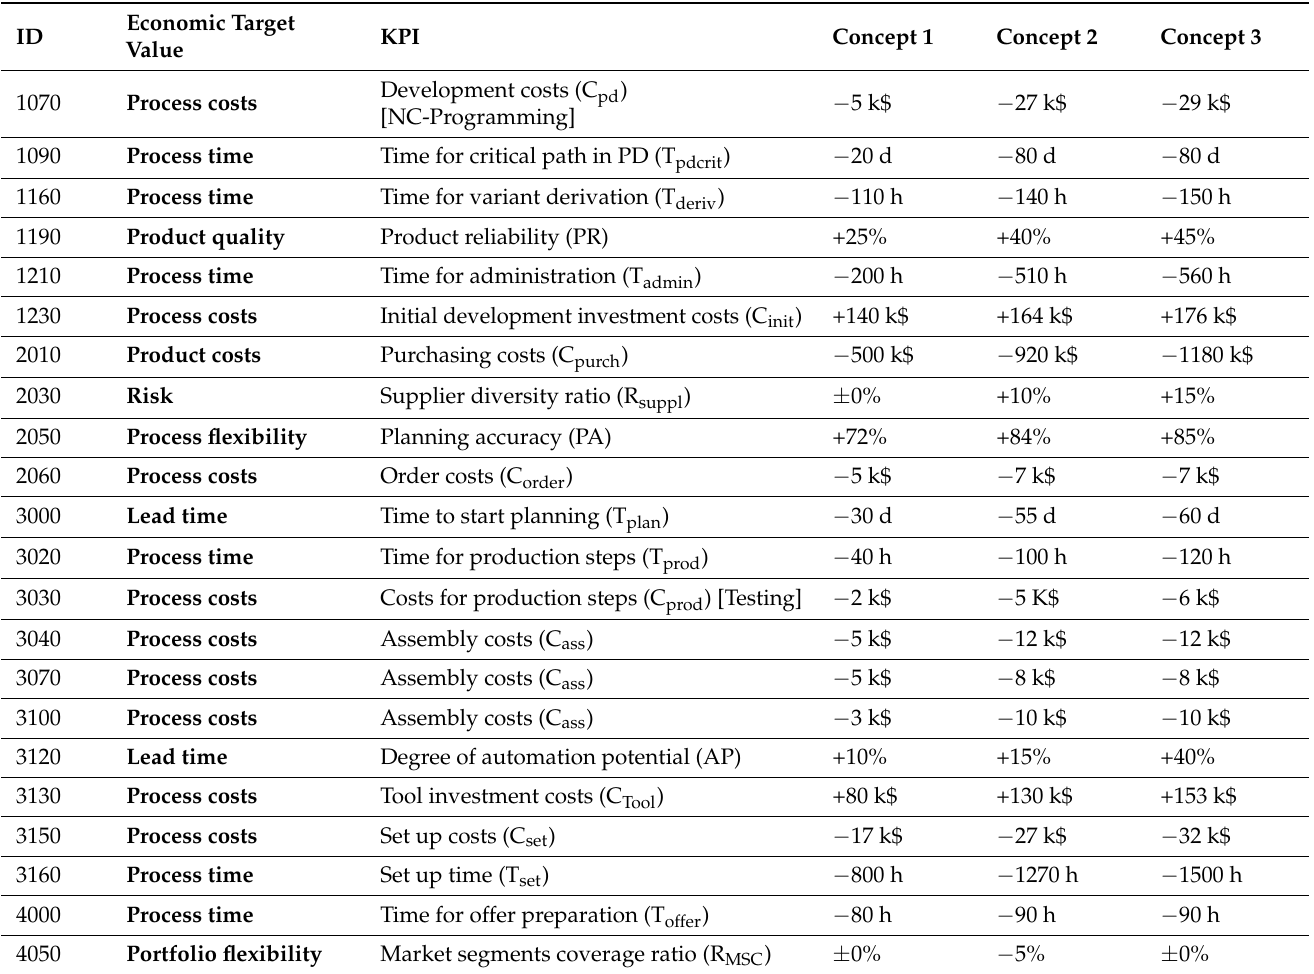
Table 3. Comparing the modular product architecture concepts from the use case using the KPIs from the extended